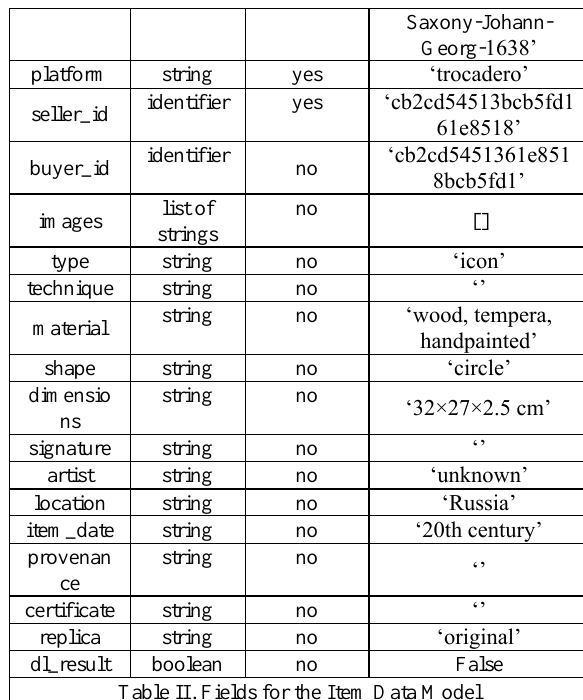
Table II. Fields for the Item Data Model